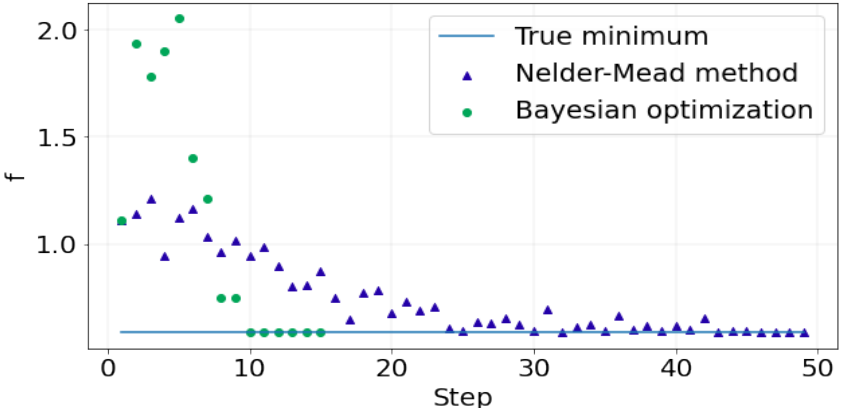
Figure 4. We compare the eBO method with the Nelder–Mead method on the matrix approximation problem on the Grassmannian. Since the optimal solution is the whole subspace, we calculated the value of function f instead of the error. The minimum of f is around 0.5578 and is plotted as the blue line in the figure. It cannot achieve zero loss due to the low dimension constraint. The Nelder–Mead method achieves the minimal subspace around 25 steps and becomes stable after 40 steps. On the other hand, the eBO method converges to the minimum after 10 steps, much faster than the Nelder–Mead method, showing the quick convergence to the optimal